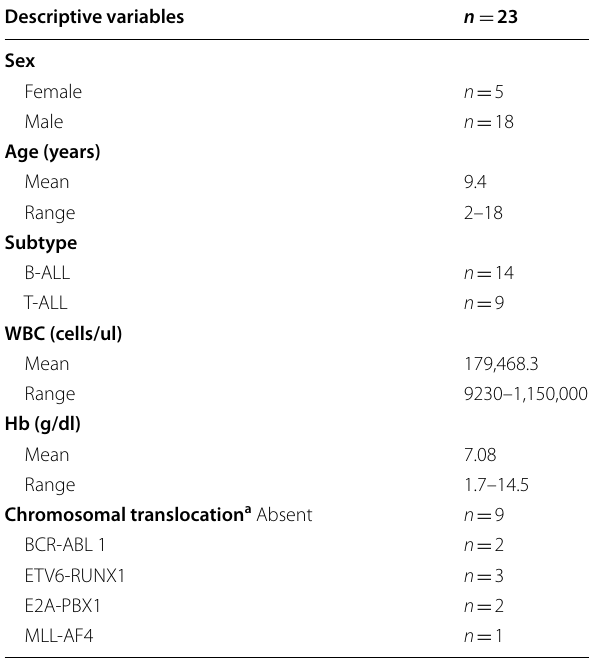
Table 1 Descriptive table listing the demographic details of the ALL